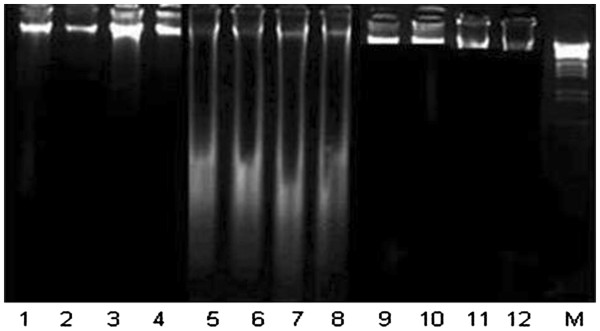
Protective effects of rutin on DNA; Lane 1–4 (non treated control), 5–8 (CCl4treated rats), 9,10 (CCl4+50 mg/kg b. w. rutin), 11,12 (CCl4+70 mg/kg b.w. rutin).